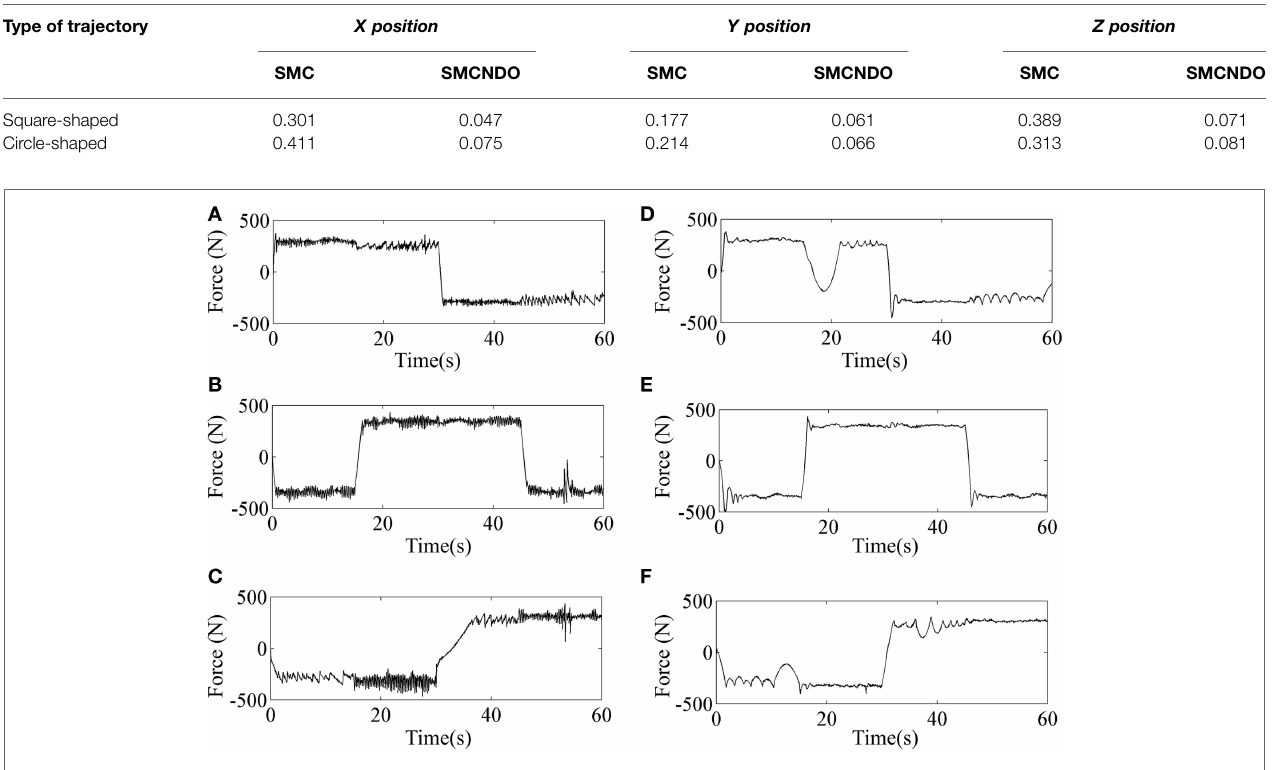
FIGURE 6 | Comparison of output forces for the three wires by implementation of sliding mode control (SMC) and sliding mode control with nonlinear disturbance observer (SMCNDO) when a healthy subject follows a square-shaped trajectory. (A) The output force for wire 1 by implementation of SMC, (B) the output force for wire 2 by implementation of SMC, (C) the output force for wire 3 by implementation of SMC, (D) the output force for wire 1 by implementation of SMCNDO, (E) the output force for wire 2 by implementation of SMCNDO, and (F) the output force for wire 3 by implementation of SMCNDO.